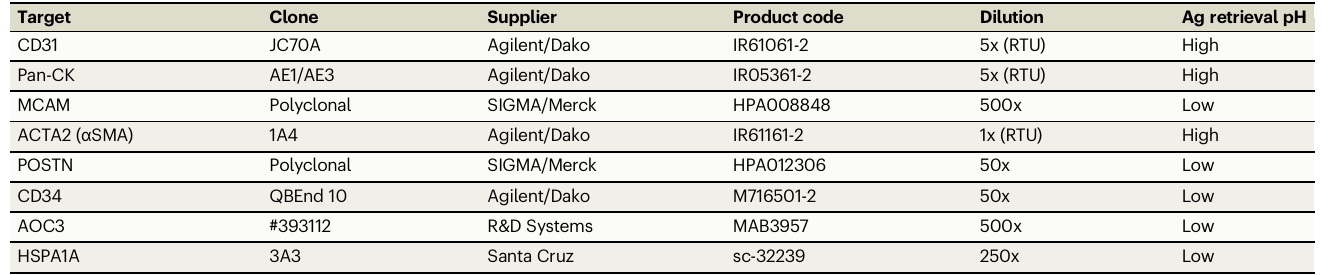
Table 1 | Details of antibodies used for multiplexed Immunohistochemistry